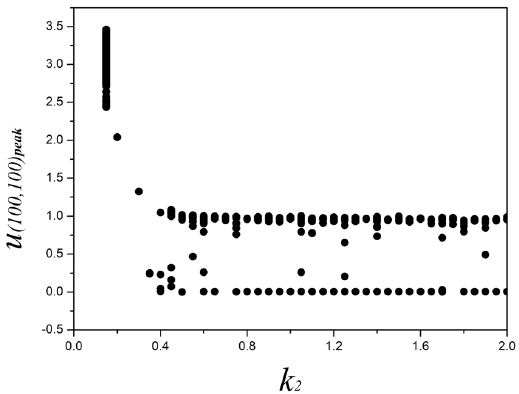
Figure 4. Bifurcation diagram for maximal membrane potential vs. k 2 , the parameters are set as k 0 = 0.1, k 1 = 0.5, α = 1, β =